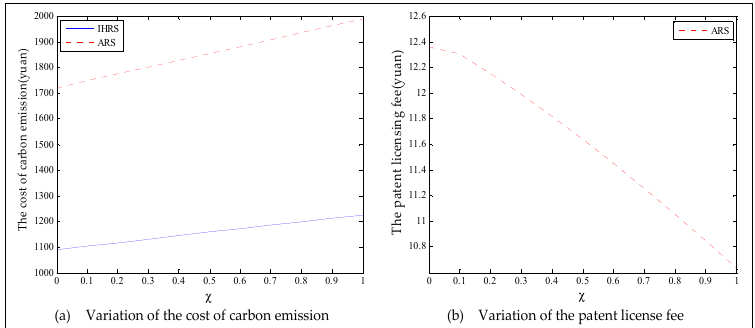
Figure 15. The variation of equilibrium strategies in Case 2 of Section 6.2.